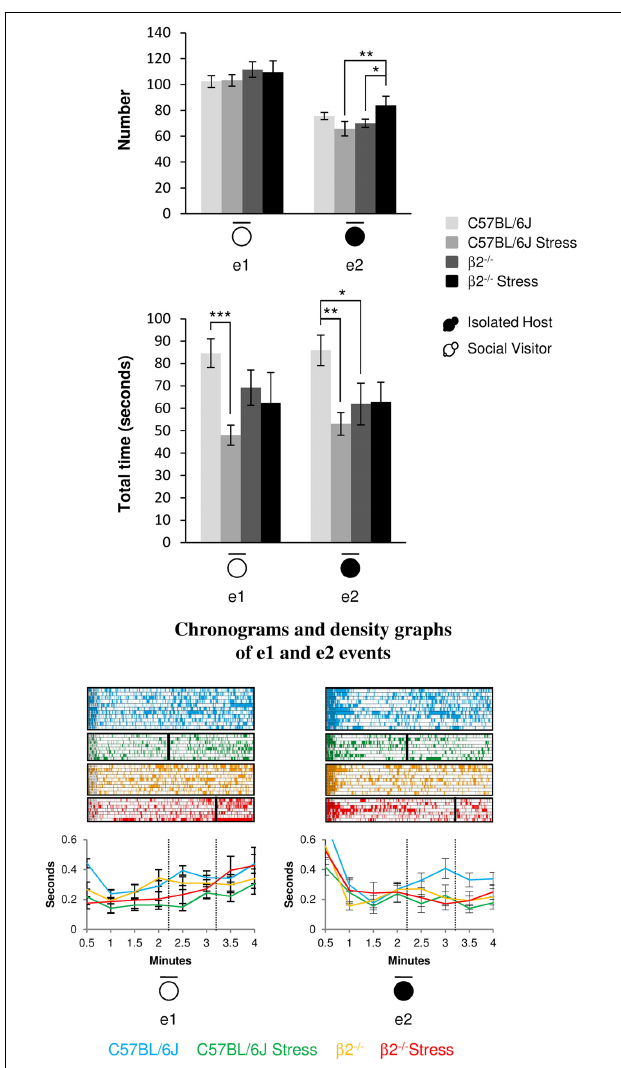
FIGURE 5 | Stop events during social interaction. The number ( Top ) and the total time ( Bottom ) of stop events of IH and SV mice in the dyads were quantified during the 4min of the social interaction task. e1: SV stop events; e2: IH stop events. IH mice were submitted or not to an acute stress. For each group, a corresponding number of SV mice was analyzed. Data are expressed as means ± SEM. ∗ p ≤ 0 . 05, ∗∗ p ≤ 0 . 01, ∗∗∗ p ≤ 0 . 001. Chronograms and density graphs (bottom) illustrated the temporal evolution of the aforementioned e1 and e2 events throughout the 4min of the experiment. In the chronograms, each line represents stop events of an individual in a specific group. The length of each point is proportional to the duration of events. In the graphs, each line represented the mean of the temporal evolution of a given event for each group of mice. Vertical lines on chronograms and density graphs indicated the average latency to first attack in stressed C57BL/6J and stressed β 2 − / − mice (full and dotted lines). C57BL/6J: blue, n = 11; C57BL/6J Stress: green, n = 8; β 2 − / − : yellow, n = 9; β 2 − / − Stress: red, n =